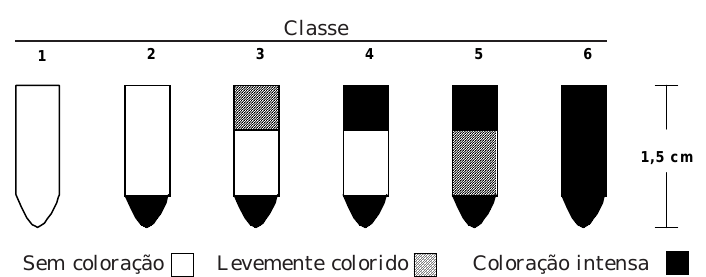
Figura 1. Avaliação do acúmulo de alumínio em raízes de plantas por meio do teste de coloração pela